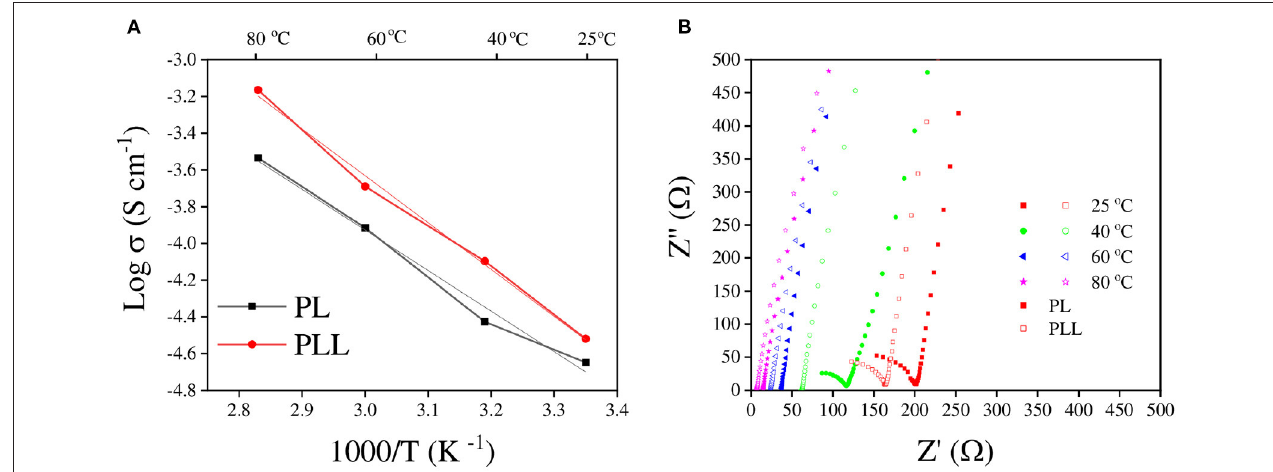
FIGURE 3 | (A) Ionic conductivity plots of the PL and PLL solid polymer electrolytes. (B) Nyquist plots of the PL and PLL solid polymer electrolytes performed at various temperatures.